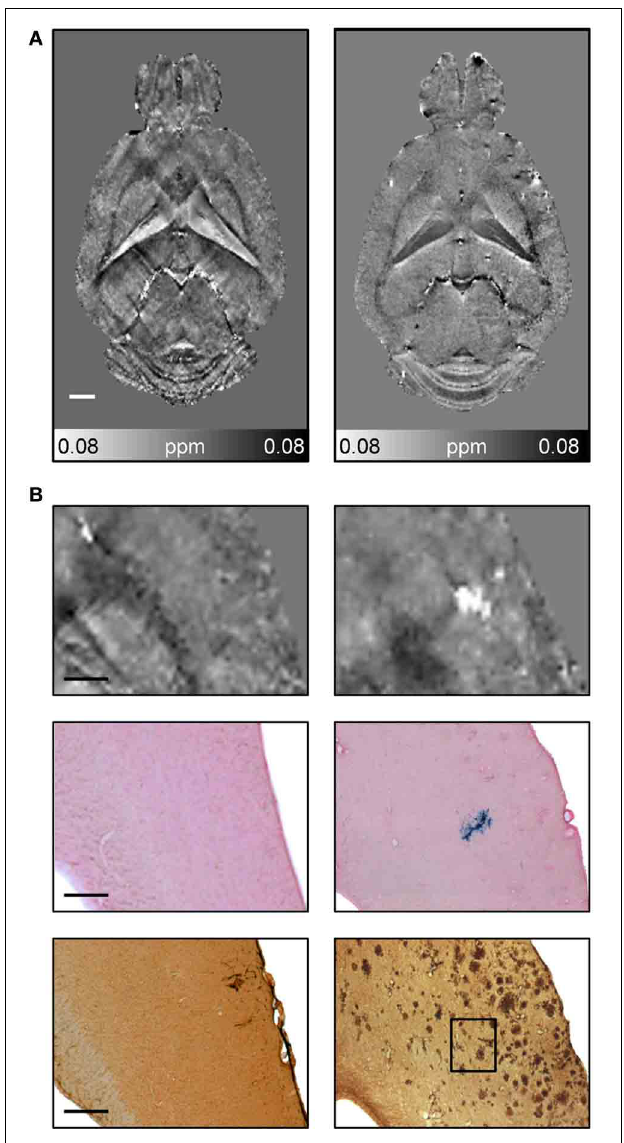
FIGURE 9 | Detection of CMBs using quantitative susceptibility mapping MRI. (A) Horizontal quantitative susceptibility maps of an 18-month-old wild type animal and of an age-matched transgenic arcA β mouse. (B) Quantitative susceptibility maps with corresponding tissue section after Prussian blue/eosin staining and anti-A β immunohistochemistry. Focal areas of high susceptibility in the cortex of 18-month old arcA β mice correspond to areas of focal iron accumulation, indicating the occurrence of cerebral microbleeds in this mouse strain. Modified from Klohs et al. (2011), © 2011